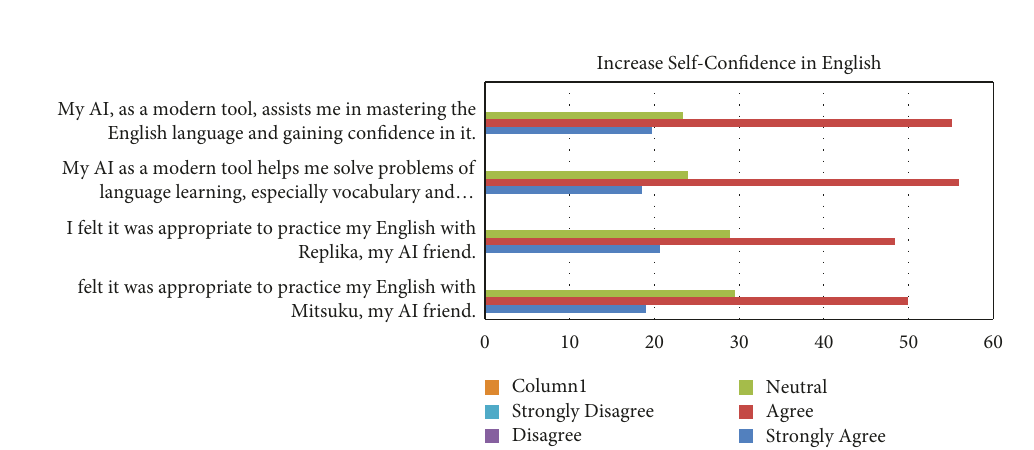
Figure 5: The AI is one solution and modern tool for EFL.